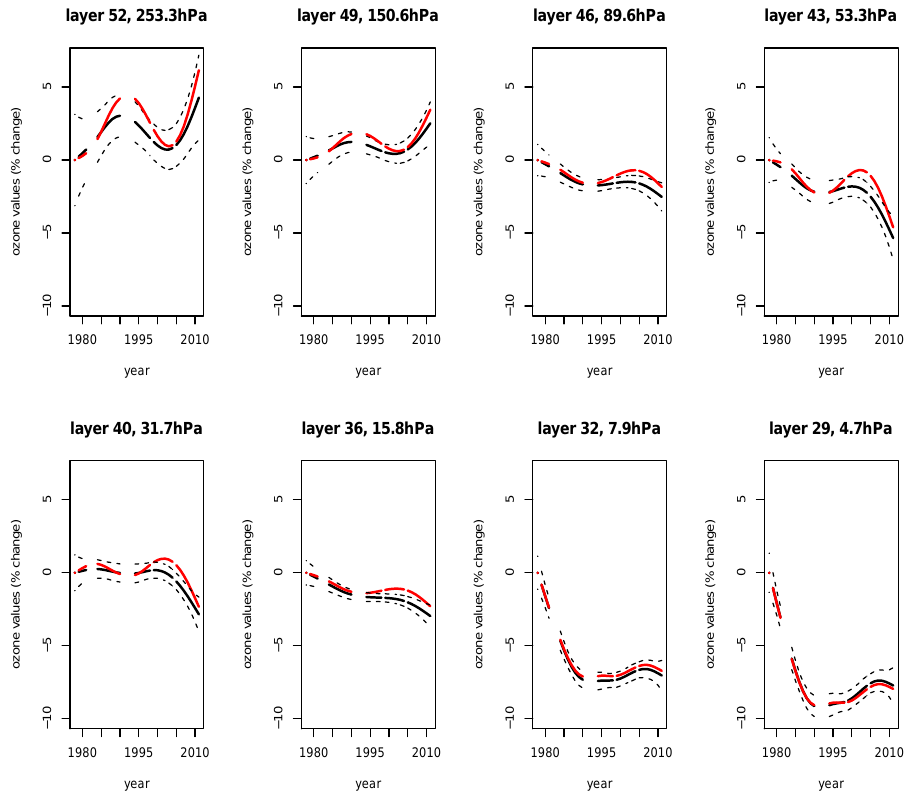
Fig. 15. Estimated ozone trends as % changes in Boulder at selected layers, with 95% confidence intervals. The trends from the full regression model are in black solid lines together with their 95% confidence intervals in dotted lines. The trends from the regression model without EP flux are in red solid lines. Volcanic years are omitted from the trend analysis.